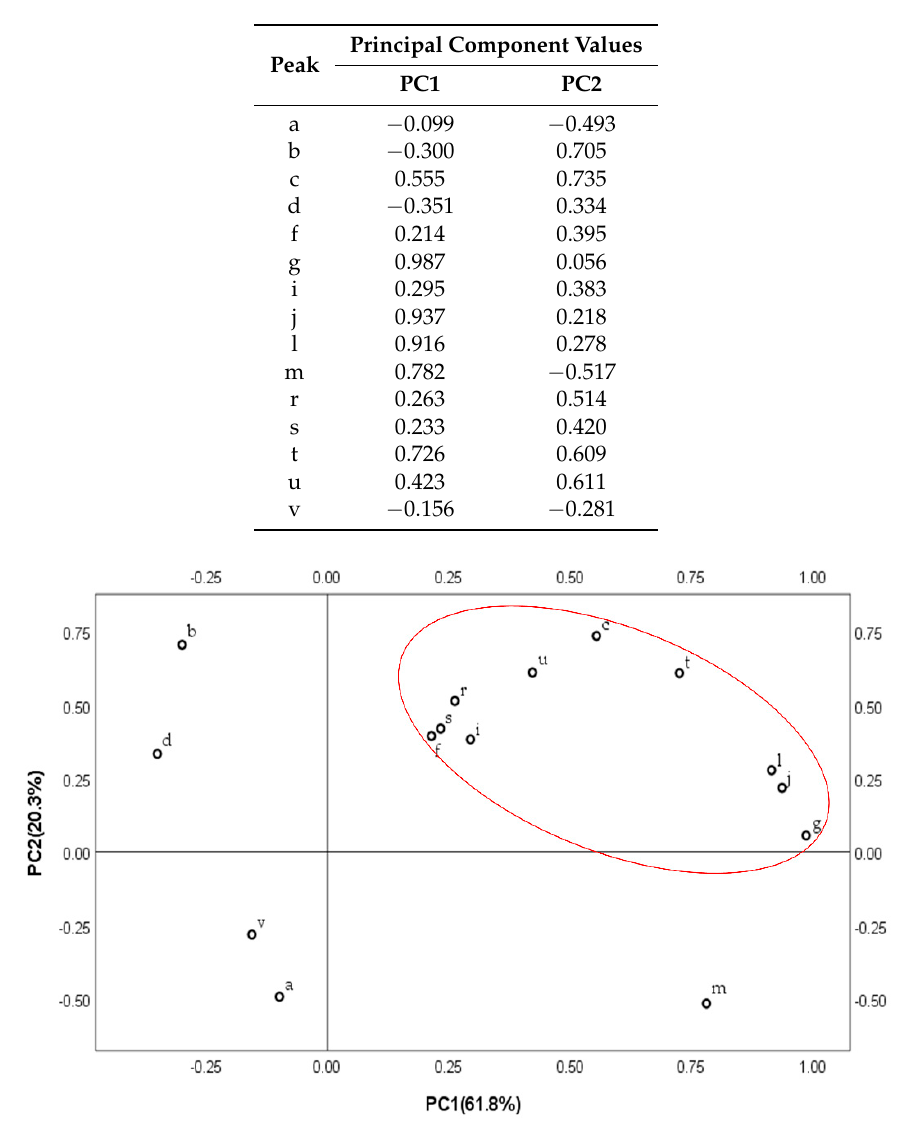
Figure 9. PCA loading plots of the sample from different sources.